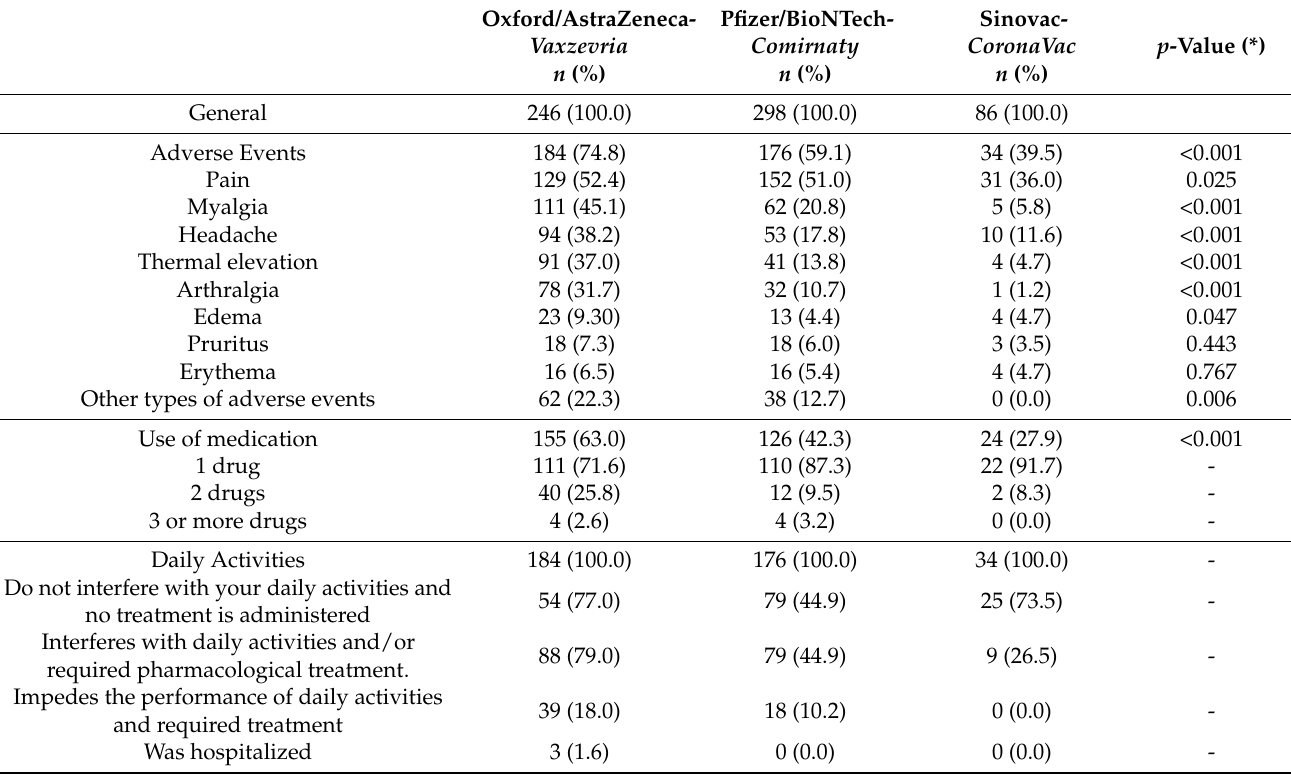
Table 3. Descriptive characteristics of adverse events, medication, and relationship to daily activities in relation to the